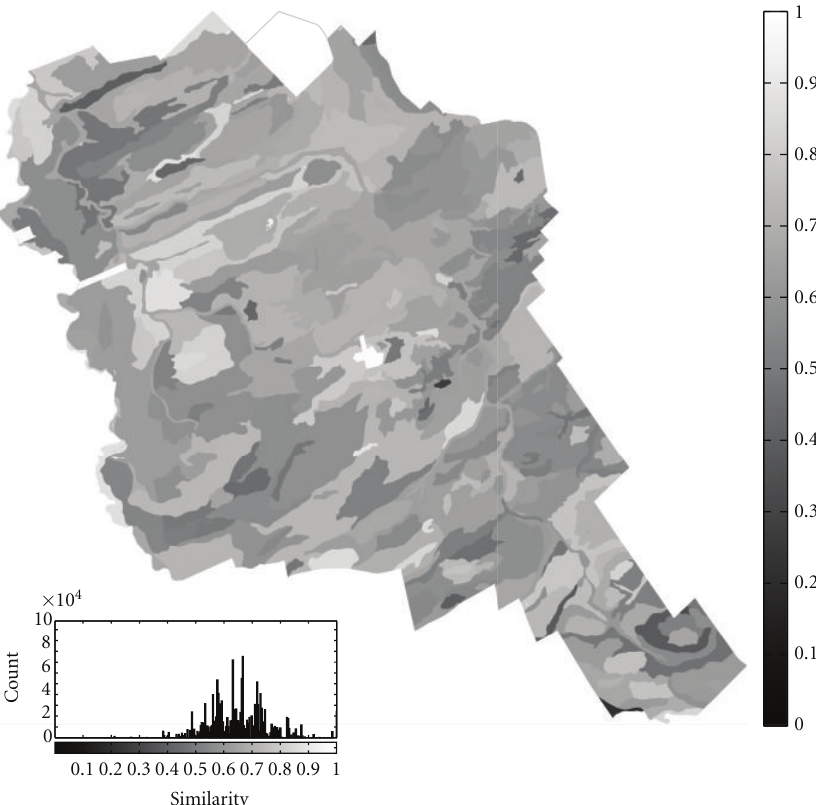
Figure 10: Map and histogram showing the spatial distribution of the similarity indice (0-1 scale) between soil drainage maps derived from the conventional soil map and the decision tree